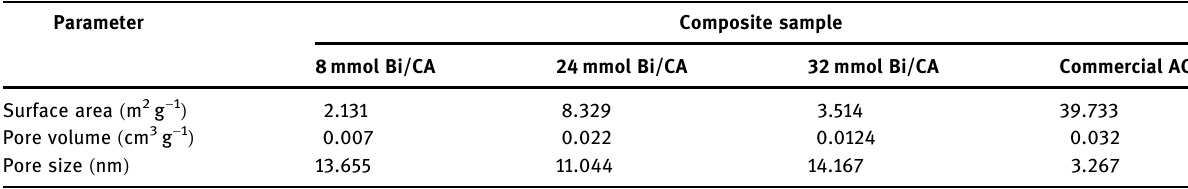
Table 4: GSA analysis results of 8, 24, and 32 mmol Bi/commercial AC composite